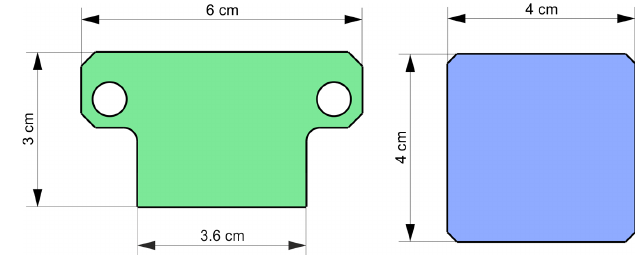
FIG. 5. Transverse cross-sections of iron plate (left) and permanent magnet